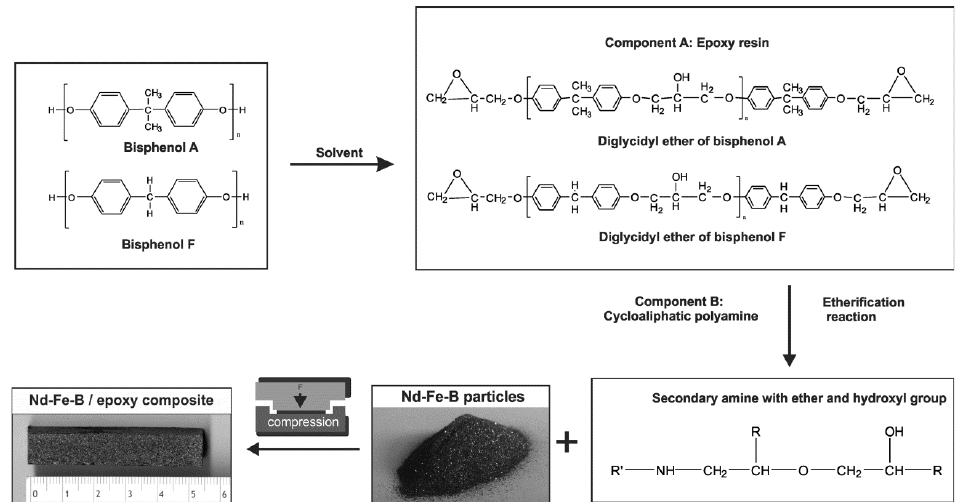
Figure 2. The mechanism of chemical reactions and production